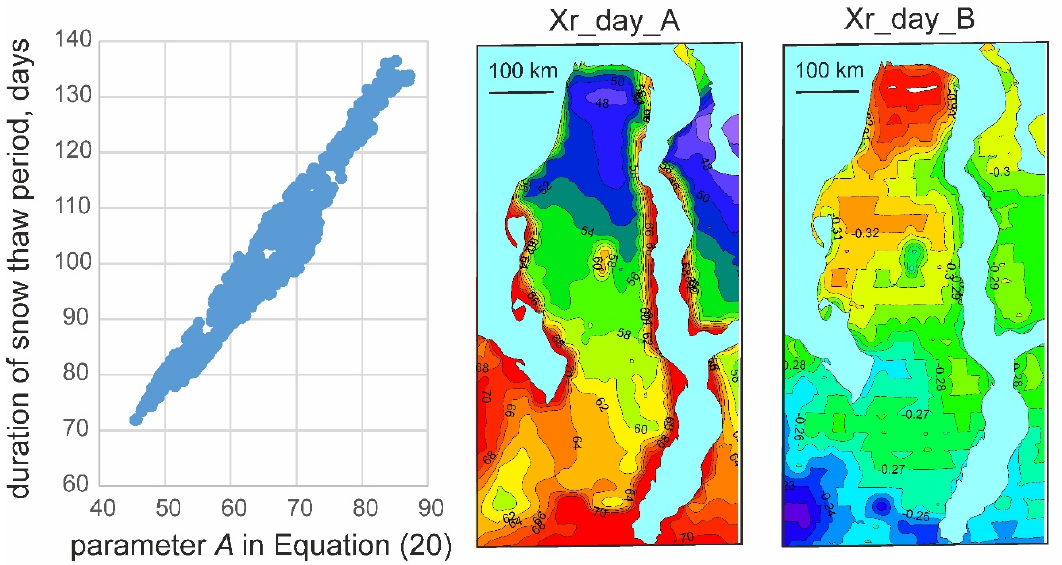
Figure 27. The relationship between parameter A and duration of summer rains period (left) and spatial distributions of parameters A and B in Equation (20) on the Yamal peninsula.